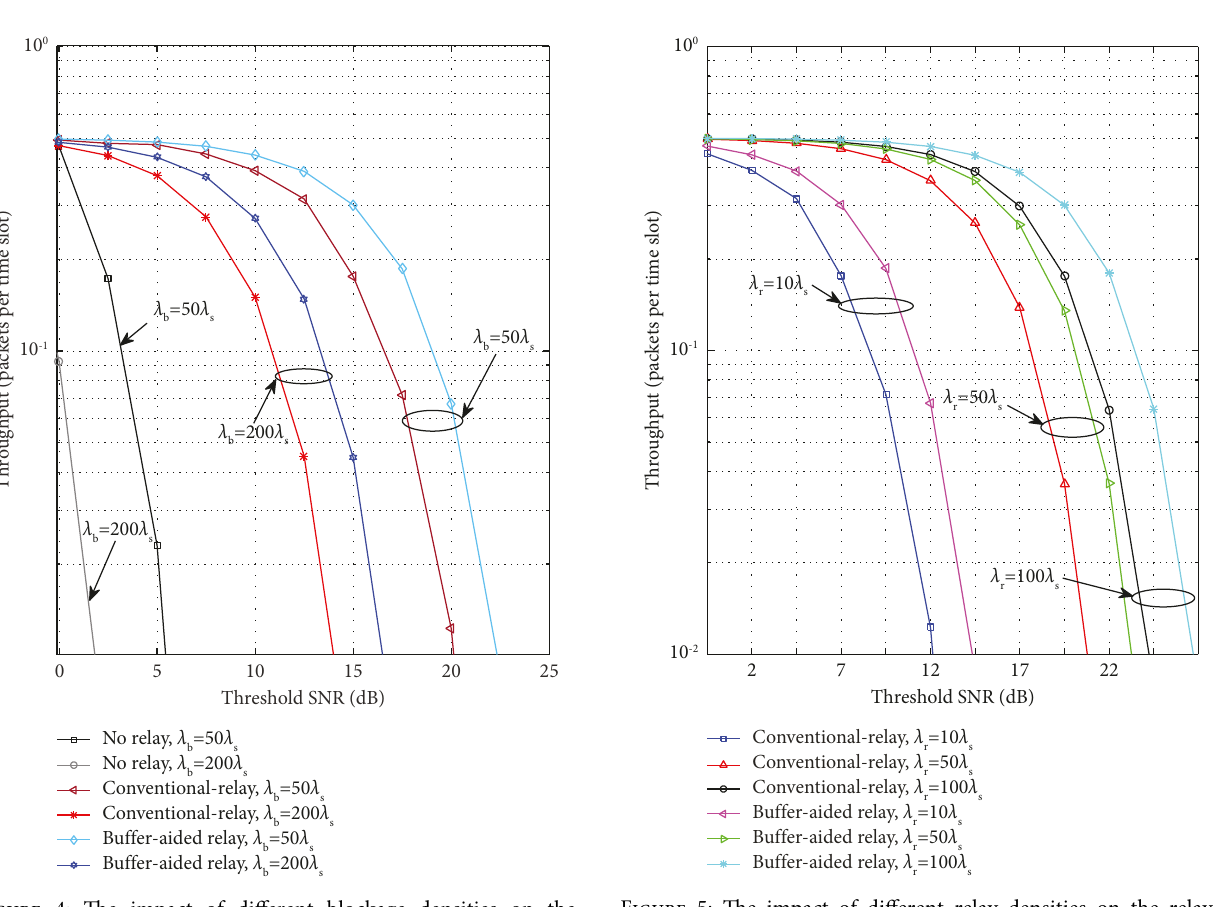
Figure 4: The impact of different blockage densities on the available solutions and the proposed solution.